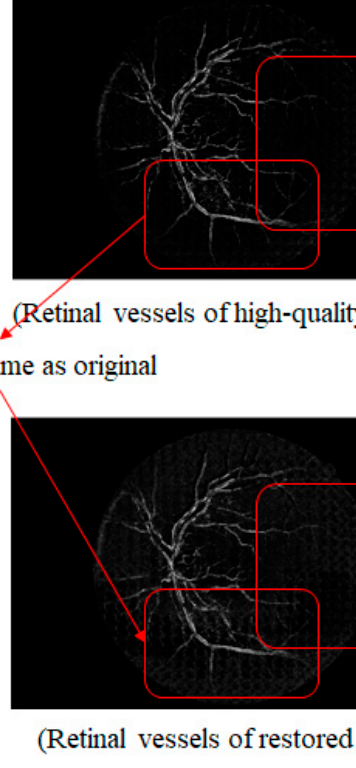
Figure 15. Comparison of high-quality retinal and synthetic vessel images.